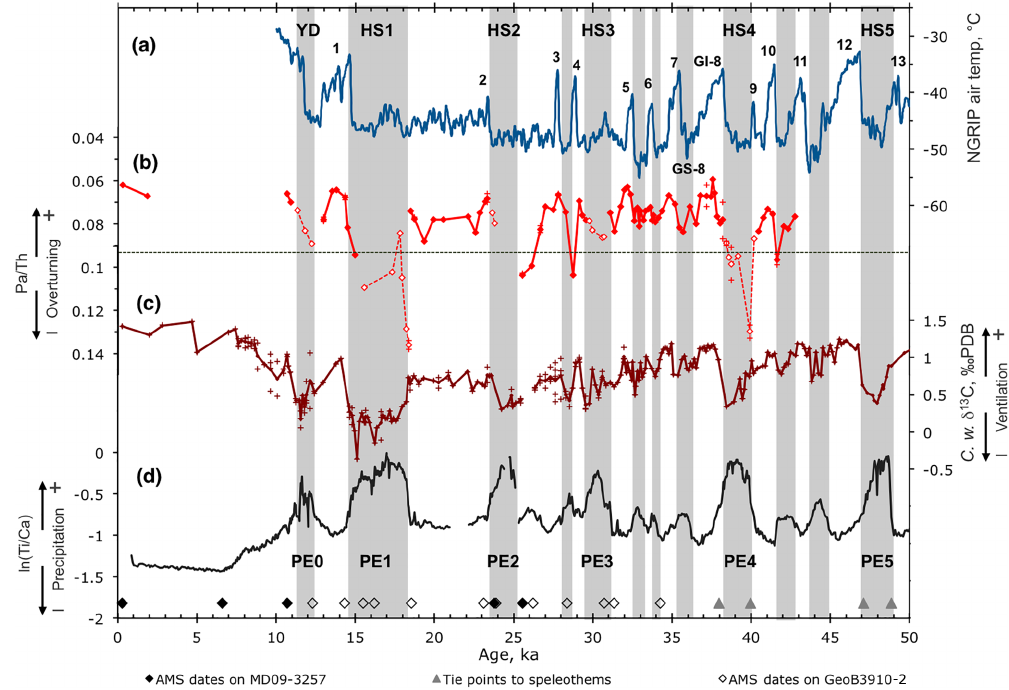
Figure 2. MD09-3257 Pa / Th, ln(Ti / Ca) and composite C. wuellerstorfi δ 13 C ( δ 13 C Cw ) records versus MD09-3257 age scale, independent from the North Greenland Ice Core Project (NGRIP) age scale. (a) NGRIP air temperature versus the Greenland Ice Core Chronology 2005 (GICC05) age scale (Kindler et al., 2014), transposed from kyr b2k (before 2000) toka. Greenland interstadials are numbered according to Rasmussen et al. (2014). To avoid overcrowding the figure, Greenland stadials (GS) and interstadials (GI) are only explicitly named in the case of GS-8 and GI-8. (b) The MD09-3257 core Pa / Th record. Empty symbols denote data points that may be affected by terrigenous fluxes and should be interpreted with caution; crosses denote replicate measurements; the red line connects average values (filled symbols). Pa / Th could not be measured over the first half of PE2 because of the occurrence of two small sand layers (Burckel et al., 2015). (c) The MD09-3257 core and GeoB3910-2 core composite δ 13 C Cw record (Vazquez Riveiros et al., 2018); crosses denote replicate measurements. (d) MD09-3257 ln(Ti / Ca). Diamonds above the x axis indicate calibrated radiocarbon dates in MD09-3257 (filled symbols) and GeoB3910- 2 (empty symbols). Triangles indicate alignment tie points to South American speleothem δ 18 O (Vazquez Riveiros et al., 2018). Grey bands delineate precipitation events recorded in MD09-3257 ln(Ti /